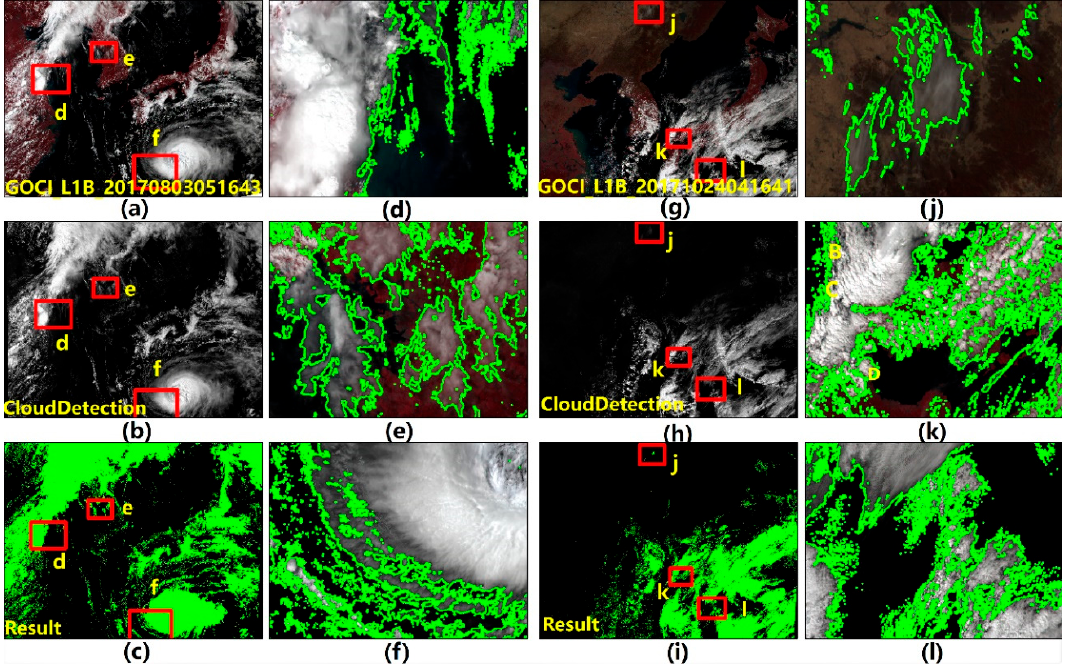
Figure 10. The original map ( a , g ) and the cloud detection results ( b , c , h , i ) obtained using the EN-Clustering method, for two selected GOCI images. ( a , g ) GOCI data acquired on 3 August 2017 and 24 October 2017, respectively. ( d ) The cloud detection results for thick clouds; ( e ) the thin clouds over the coastal area; ( f ) the thin and thick cloud detection results over the ocean; ( j ) the cloud detection results over bare land; ( k ) the cloud detection results for thick clouds, thin clouds, and small pieces of broken cloud over the coastal area; and ( l ) the thin cloud, thick cloud, and broken cloud detection results over the ocean.